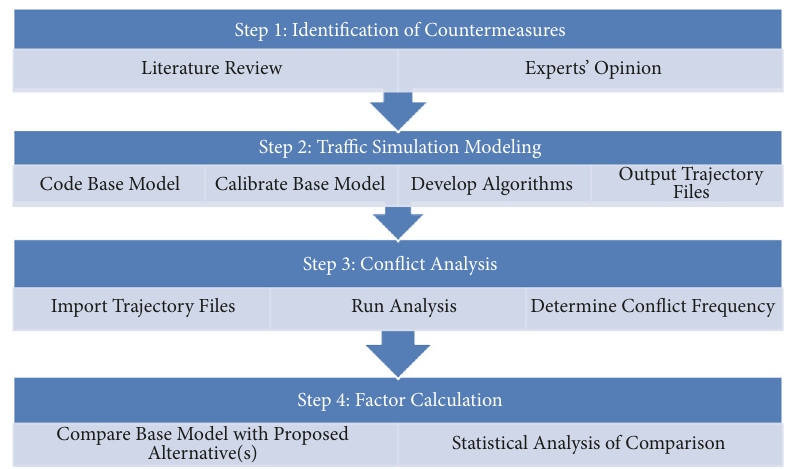
Figure 1: Proposed method for estimating